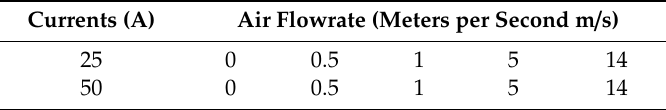
Table 1. Experimental data collection operating